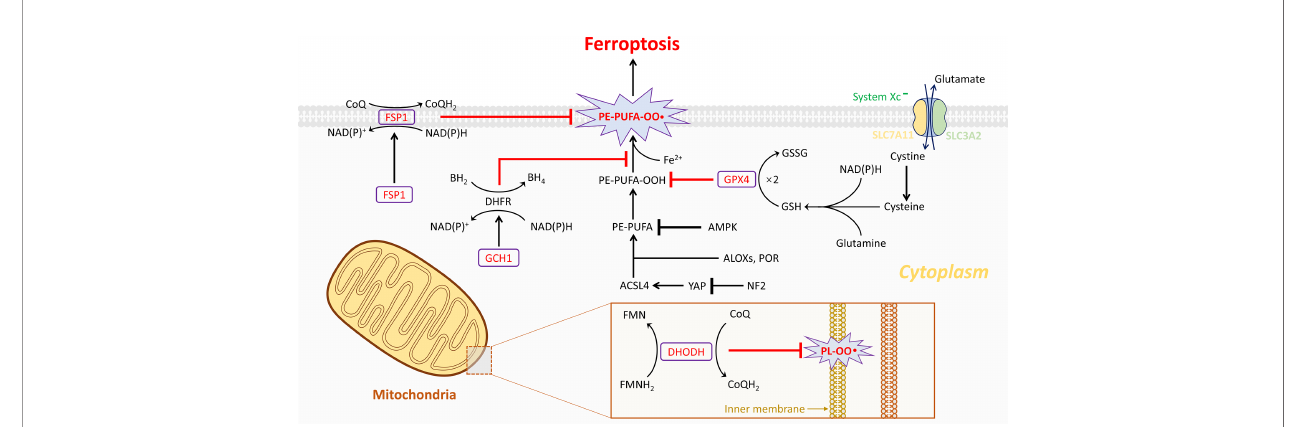
FIGURE 1 | The four current known regulation systems in ferroptosis. Overall, lipid peroxidation in ferroptosis is under control of GPX4-, FSP1-, GCH1-, and DHODH-dependent systems. GPX4 is the most important gatekeeper for ferroptosis and bolstered through the sustainment of GSH and cystine transportation of system Xc - activation. System Xc - is composed of two essential subunits, SLC7A11 and SLC3A2. Generally, ferroptosis could be triggered by GPX4 inhibition directly or indirectly. Nonetheless, several cancer cell lines are resistant to GPX4 inhibition through activating additional regulation systems like FSP1/CoQ 10 and GCH1/BH4 systems in the cytoplasm. These two independent manners play a critical role in mitigating cellular ferroptosis especially during loss of GPX4. However, the dysfunction of the three abovementioned systems is observed in organelles such as mitochondria. Notably, then the fourth antioxidant system DHODH-mediated ferroptosis protection in mitochondria is revealed. In the inner membrane of mitochondria, DHODH suppresses ferroptosis via the conversion of ubiquinone to ubiquinol that fi ghts against oxidative damage on the phospholipid membrane. A total of four gatekeepers presumably serve as potential targets for the treatment of osteosarcomas. Except the four pathways, other pathways are also important in regulating ferroptosis, such as ACSL4, AMPK-ACC2, and NF2-YAP pathways, which have been known to affect ferroptosis by regulating PUFA metabolism and cellular phospholipid composition. Lipoxygenases (ALOXs) and POR have been known to affect ferroptosis by driving lipid peroxidation, which play opposite roles to GSH-GPX4, FSP1-CoQ10, GCH1-BH4, and